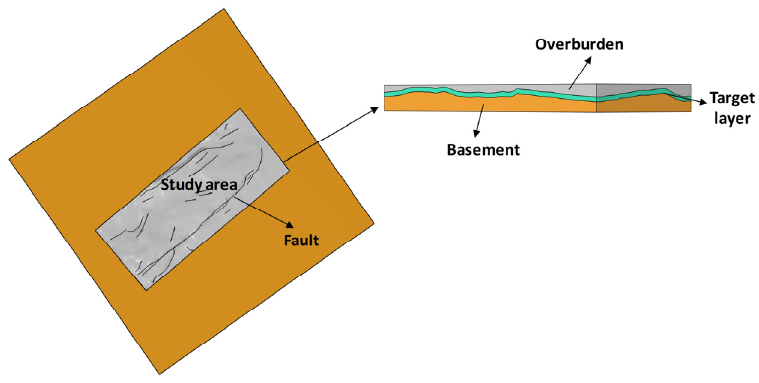
Figure 5. Three-dimensional structure model of the target layer in the study area.